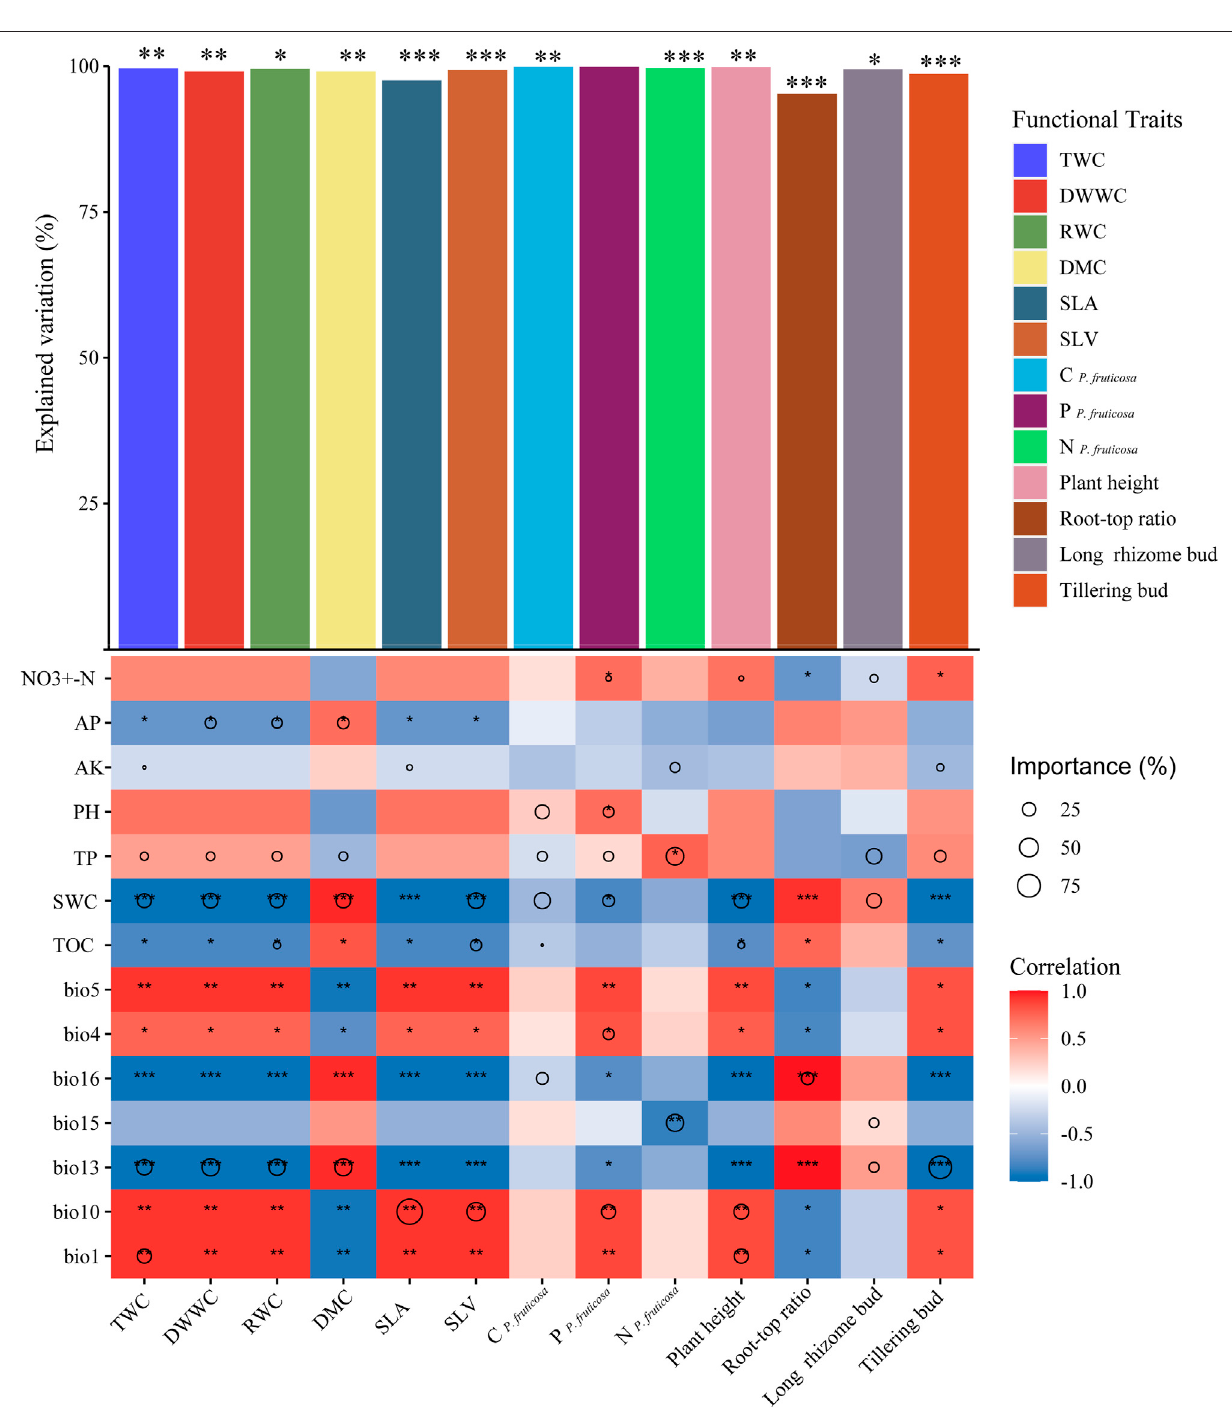
Frontiers in Environmental Science |